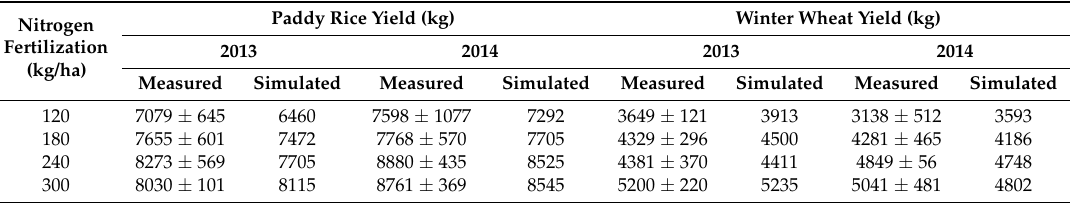
Table 1. Simulated and measured yield of paddy rice and winter wheat in the 2013 and 2014 growing seasons